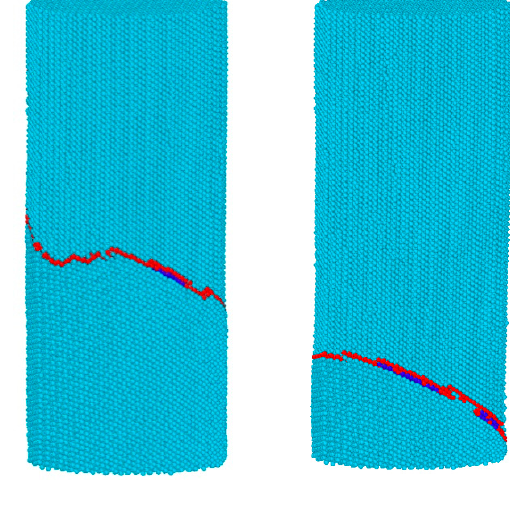
Figure 4. Bi-crystal Mg nanopillar for which atoms in the TB are not fixed.